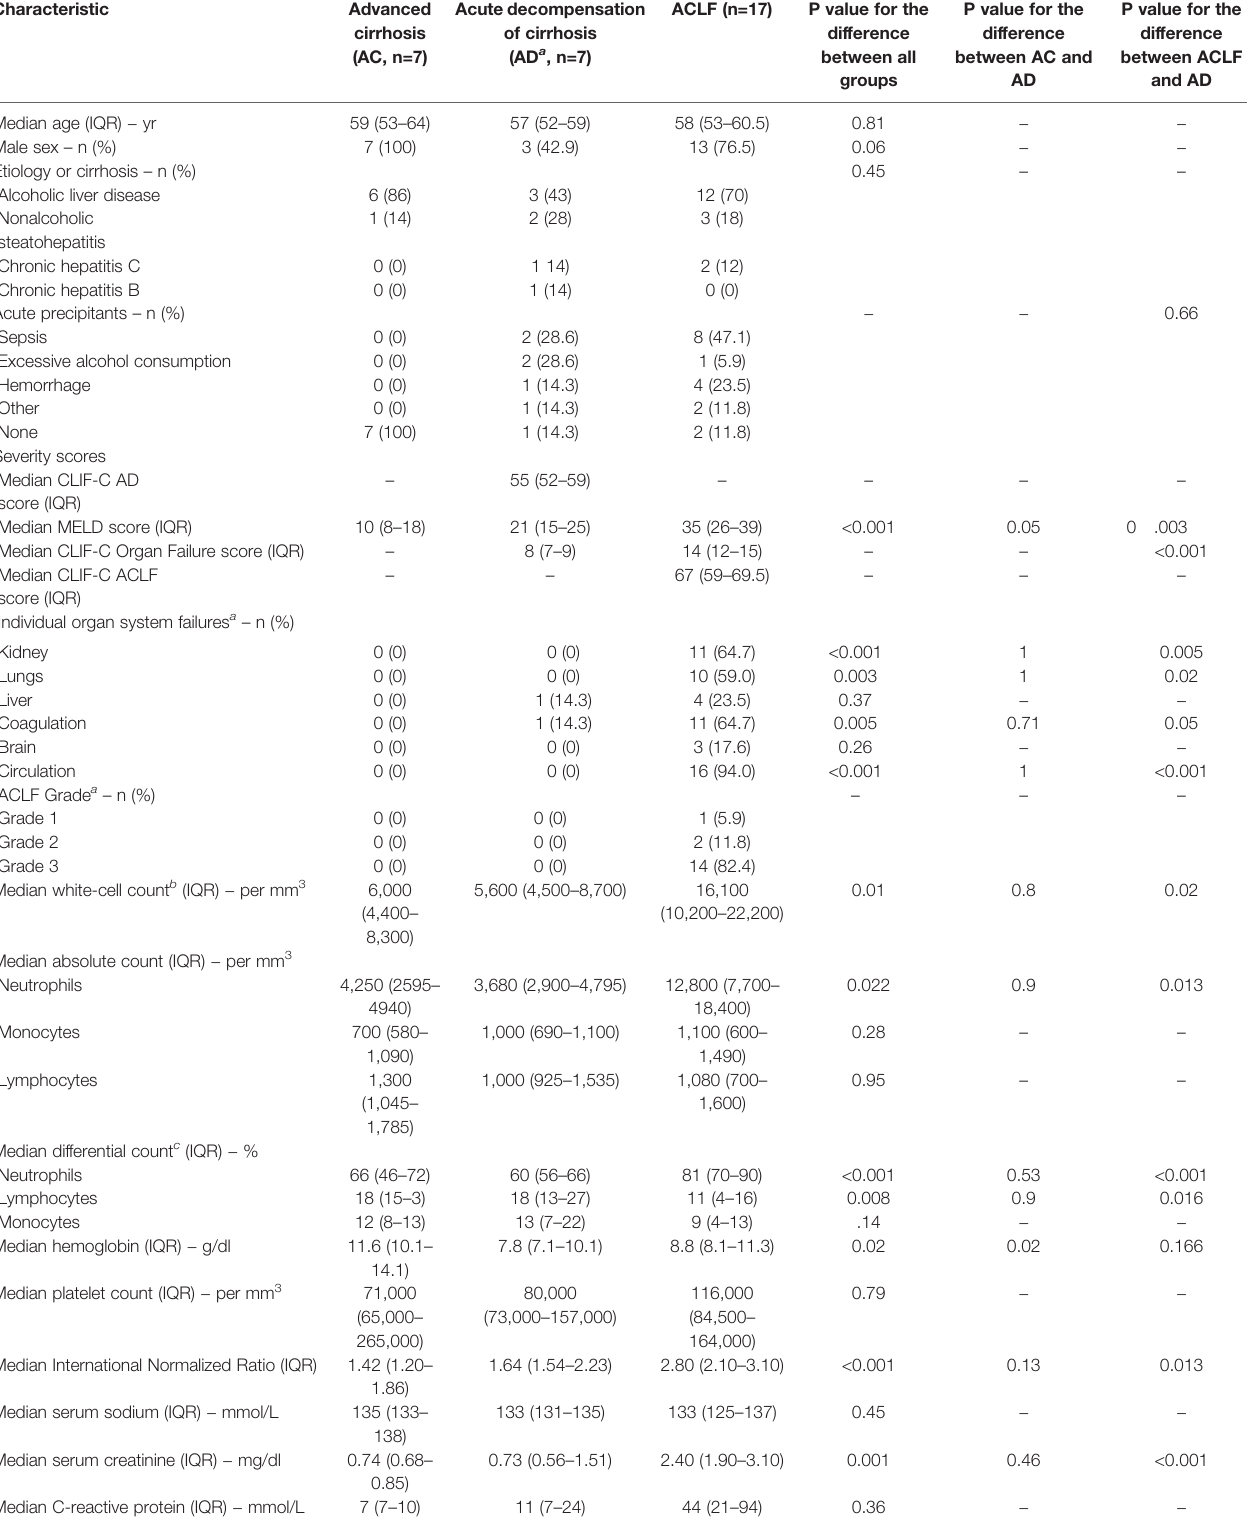
TABLE 1 | Characteristics of the French patients with cirrhosis enrolled for the whole-blood transcriptome analysis.